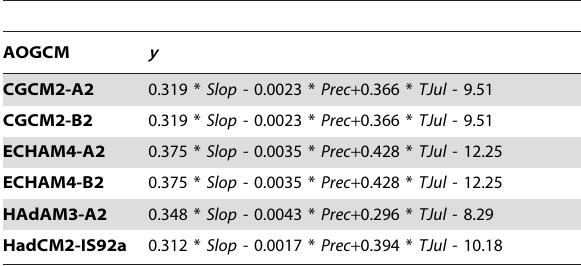
Table 3. Coefficients in the logit function ( y ) of the favourability models for the period 1961–1990.